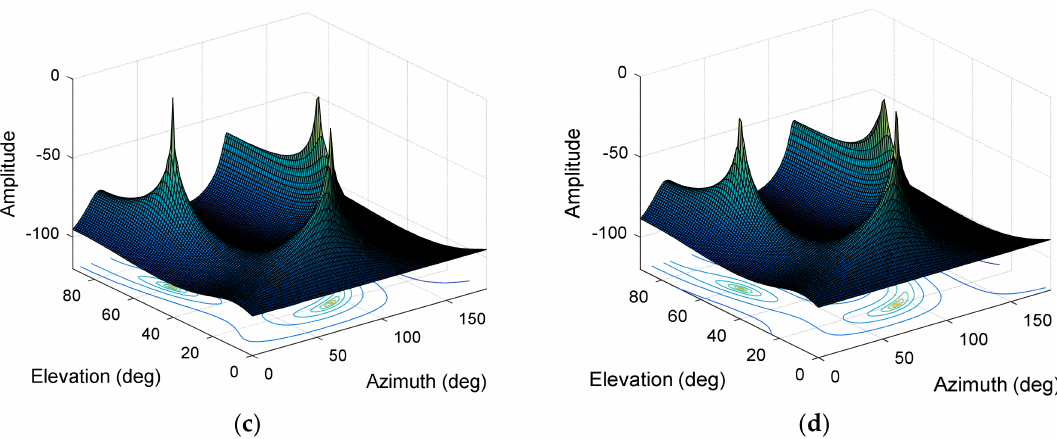
Figure 7. The normalized spectral function. ( a ) The normalized spectral function at K = 4; ( b ) The normalized spectral function at K = 8; ( c ) The normalized spectral function at K = 12; ( d ) The normalized spectral function at K = 15.